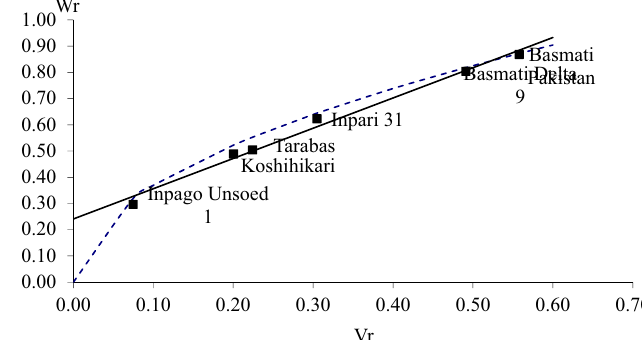
Figure 2: Covariance ( W r ) and variance ( V r ) graph of rice